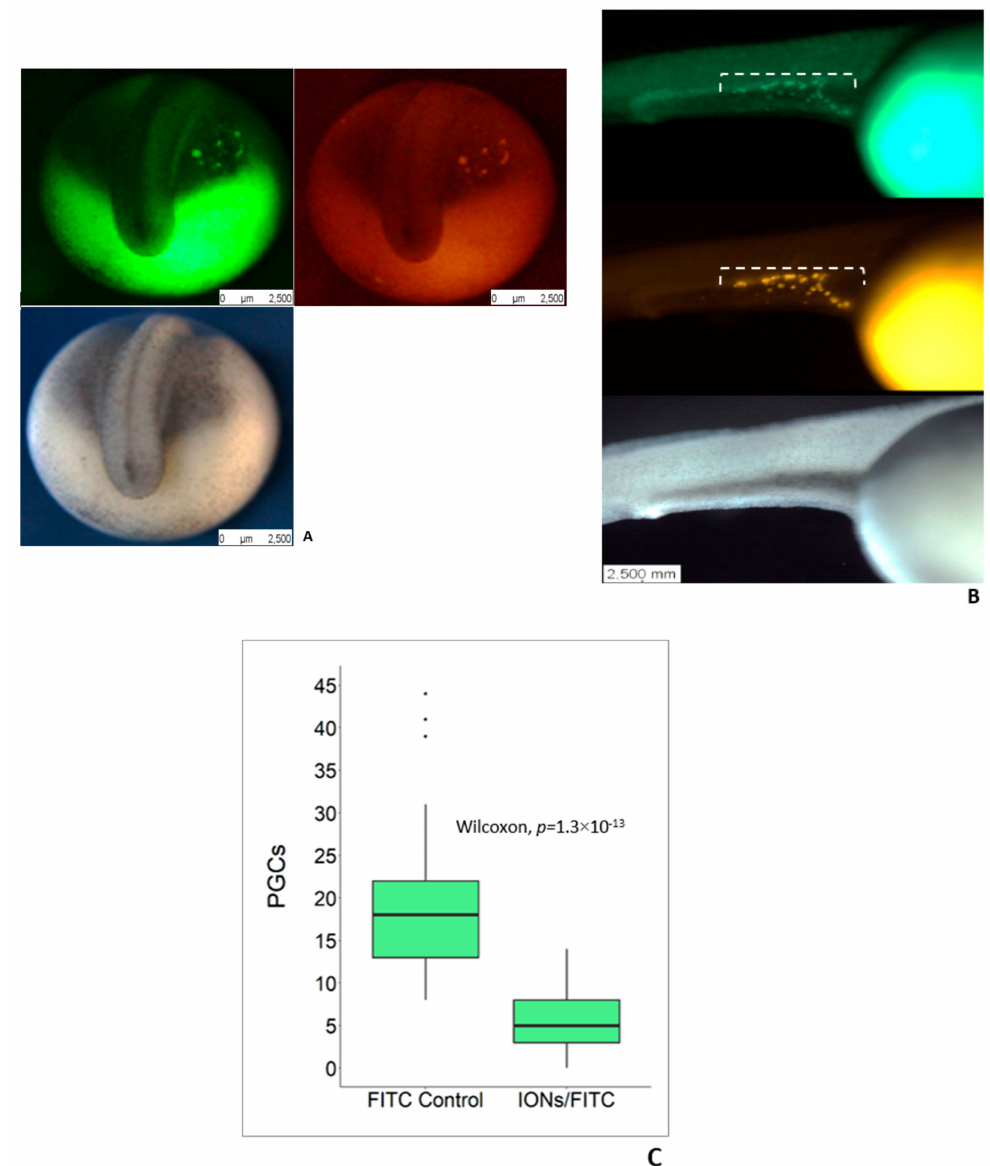
Figure 2. Labelling of primordial germ cells (PGCs) in sturgeons by using IONs and their visualization under fluorescent stereomicroscope. ( A ) IONs / FITC-dextran injected embryos to deliver IONs into PGCs at the tail bud stage. Visualization of PGCs in IONs / FITC-dextran injected embryos at 4 dpf; left: FITC-dextran labelling; right: IONs delivered into PGCs; bottom: Bright field view. ( B ) Visualization of PGCs in IONs / FITC-dextran injected group at 5 dpf. PGCs can be clearly seen under white